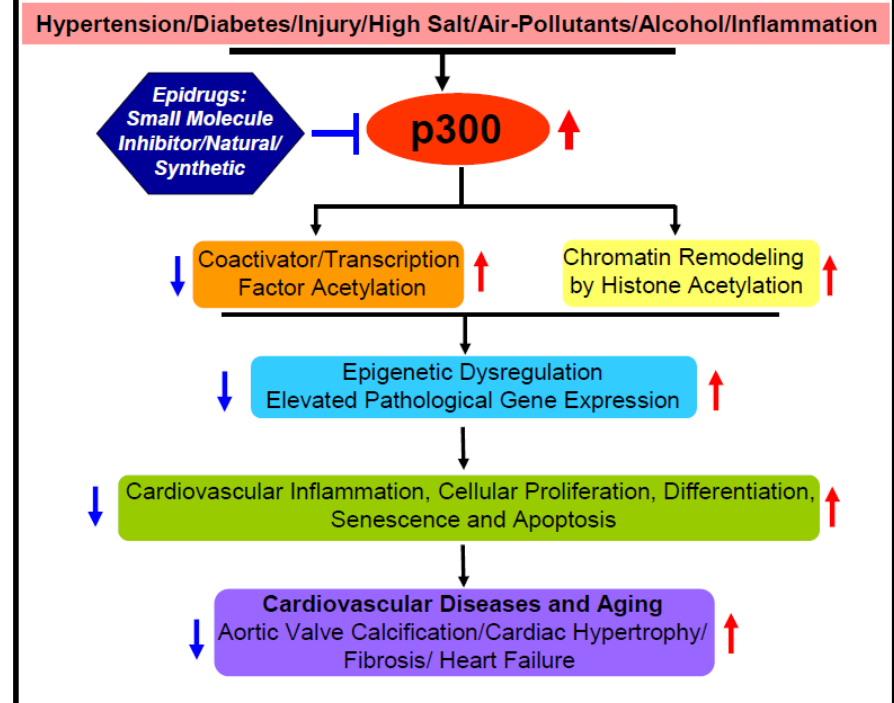
Figure 2. Model depicting the possible contribution of acetyltransferase p300 in cardiovascular disease.